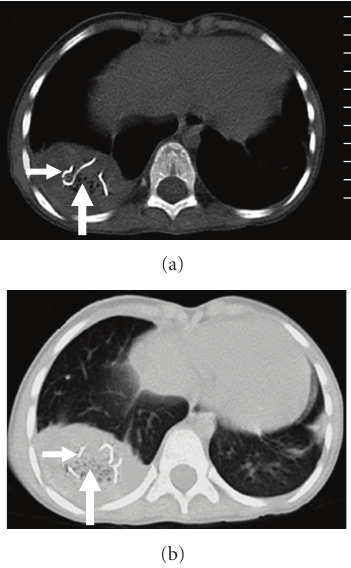
window (a) and lung window setting (b) showing a well-defined, hypodense, pleural based mass in the right lower hemithorax. The whorl-like structure is representing the sponge itself, which is having air droplets (Large Arrows) and a thin, coiled structure of high density in core of the lesion, representing the radio-opaque markers (Small